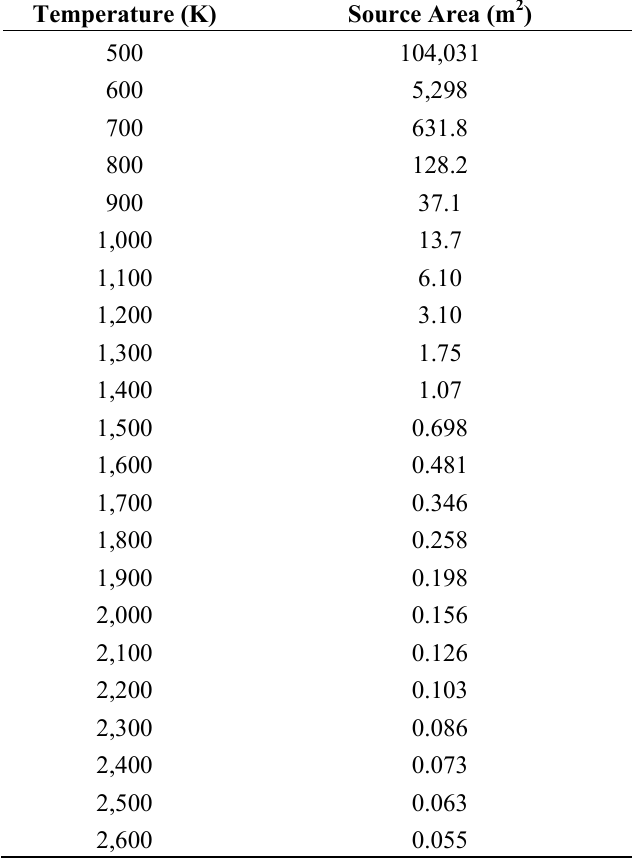
Table 2. Nightfire Source Area Detection Limits by